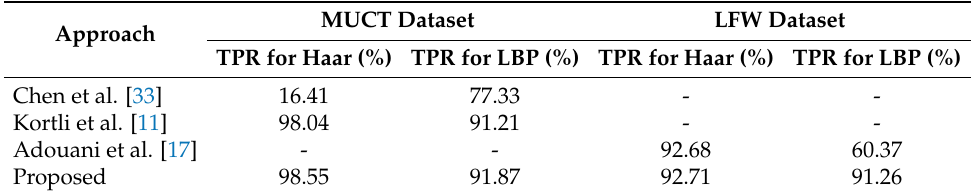
Table 4. Comparisons of our approach with three recent approaches using the same database.